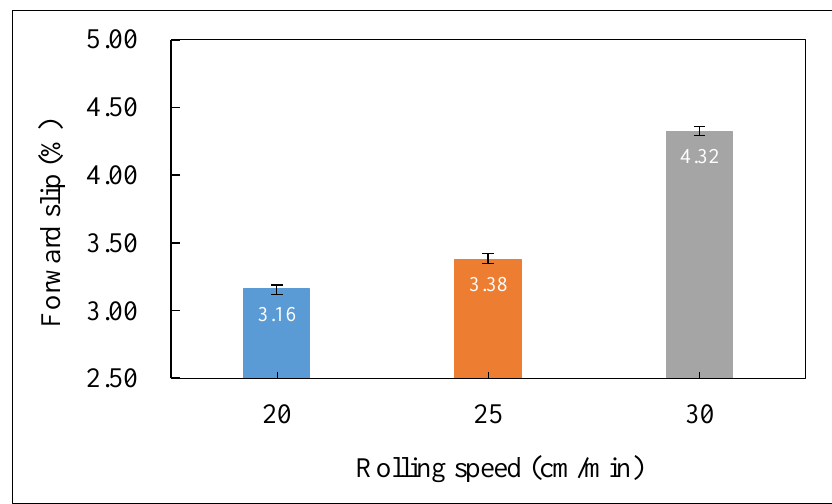
Figure 7. Variation of forward slip with rolling speed for the rolling phase with thinner thickness.